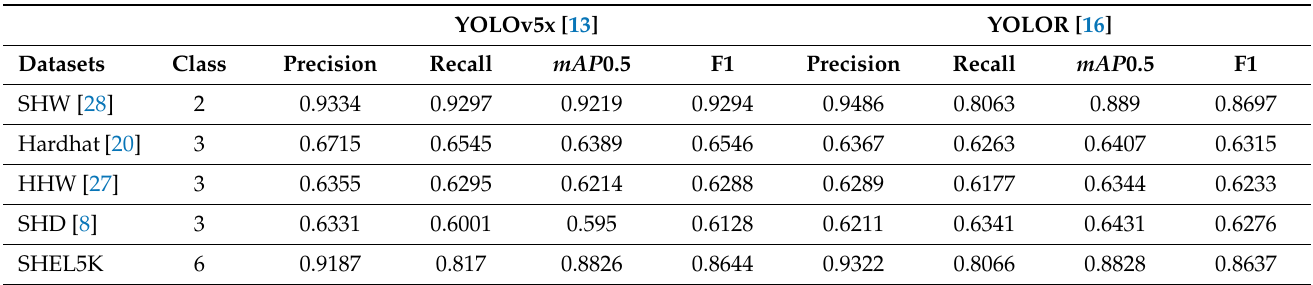
Table 5. The result of the YOLOv5x [13] and YOLOR [16] models on the publicly available datasets and the proposed SHEL5K dataset.